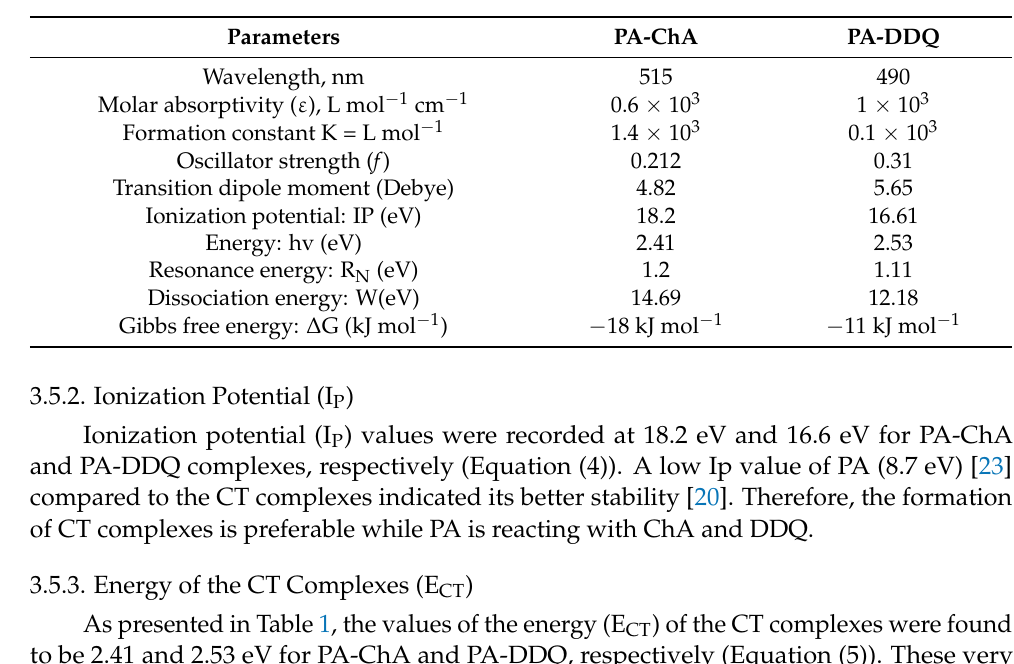
Table 1. Spectroscopic characteristics of procainamide CT